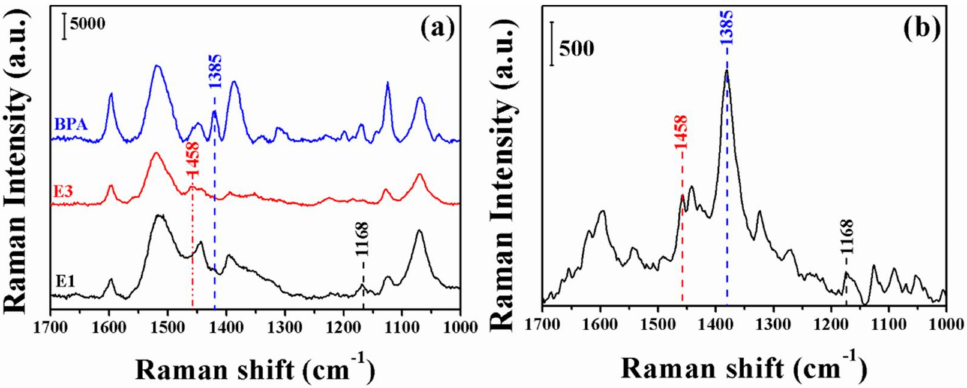
Figure 7. SERRS spectra of the estrogen-derived azo dyes from estrogen mixtures (E1, E3 and BPA) ( b ); and their individual spectra (each estrogen was at a concentration of 1.0 × 10 − 4 M) ( a